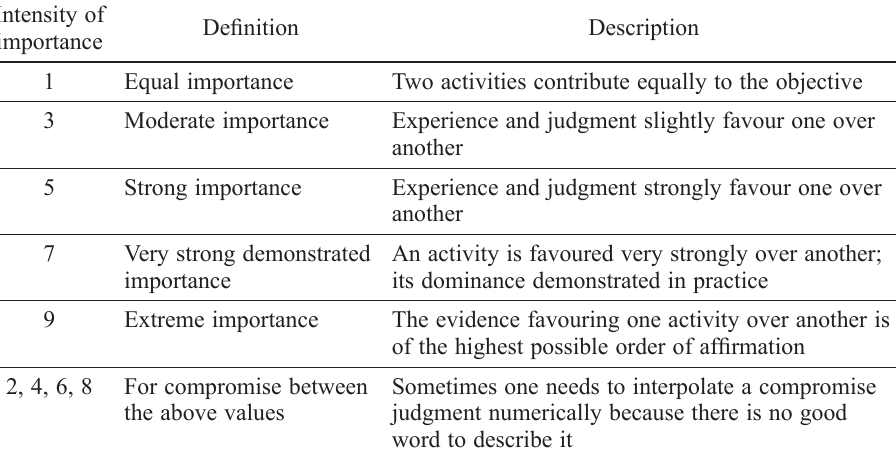
Table 1. Description of the pair-wise comparison